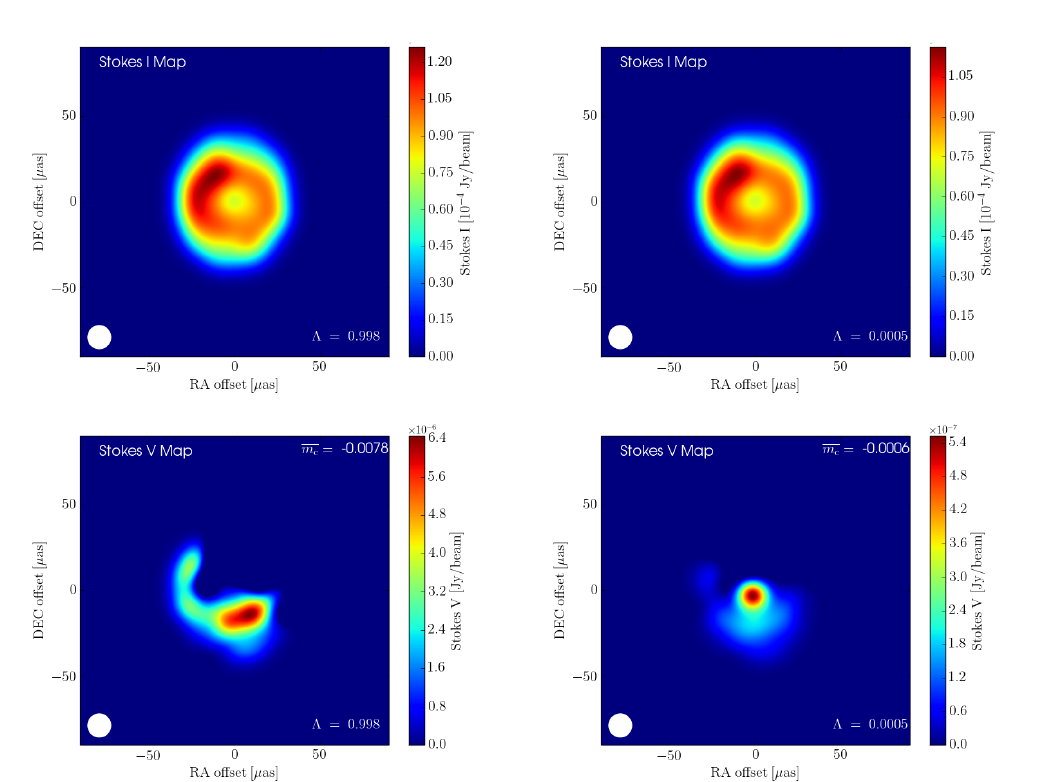
Figure 4. ( Upper left panel ) Stokes I image for a jet composed of a normal plasma with a proton-to-positron ratio of 1000 ( Λ = 0.998). ( Upper right panel ) Stokes I image for a jet composed of a pair plasma with a proton-to-positron ratio of 0.001 ( Λ = 0.0005). ( Lower left panel ) Corresponding Stokes V image for the normal plasma. ( Lower right panel ) Corresponding Stokes V image for the pair plasma. The above images have all been convolved with the circular Gaussian beam (shown in the lower left of each image), and were all created from the disordered TEMZ model (Figure 2, lower panel) at ν obs = 43 GHz. The integrated level of fractional circular polarization ( m c ) is listed in the upper right of the Stokes V images. For ease of visualization, we have masked the negative Stokes V